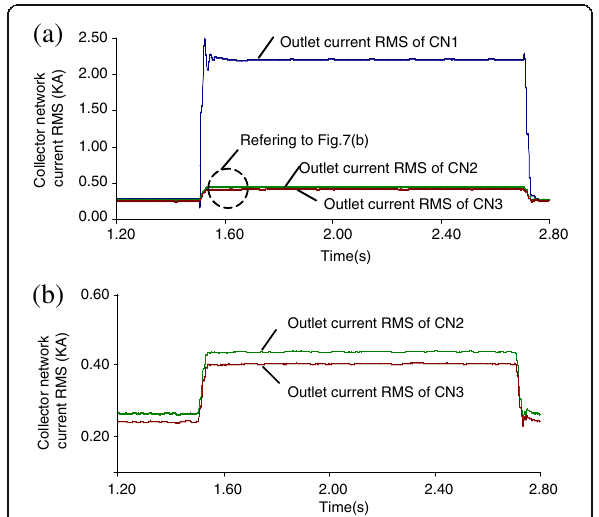
Fig. 7 a Collecting power lines current RMS waveforms for k1 fault